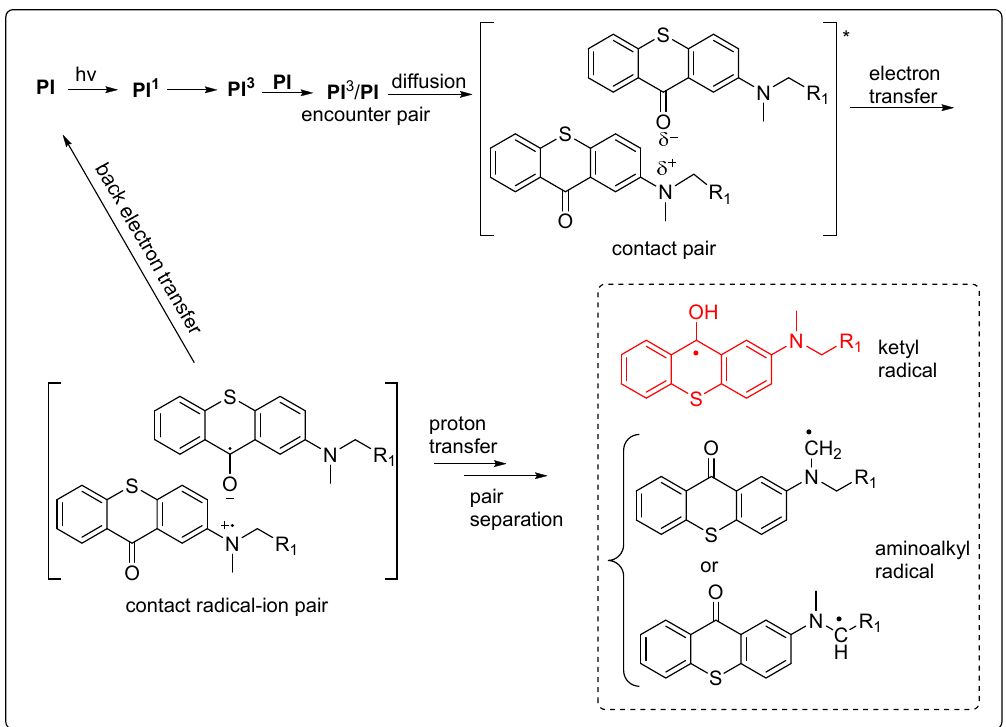
Figure 1. The normalized UV-vis spectral changes of the photoinitiator in THF under xenon lamp Figure 1. ThenormalizedUV-visspectralchangesofthephotoinitiatorinTHFunderxenonlampexposure exposure (I = 57 mW cm − 2 ), ( a ): STX ([STX] = 2 × 10 − 4 mol/L = 0.19 g/L); ( b ): TX-B ([TX-B] = 2 × 10 − 4 mol/L). (I = 57 mW cm − 2 ), ( a ): STX ([STX] = 2 × 10 − 4 mol / L = 0.19 g / L); ( b ): TX-B ([TX-B] = 2 × 10 − 4 mol / L). [STX] refers to the molar concentration of the ATX moiety. [STX] refers to the molar concentration of the ATX moiety. Polymers 2019 , 11 , x FOR PEER